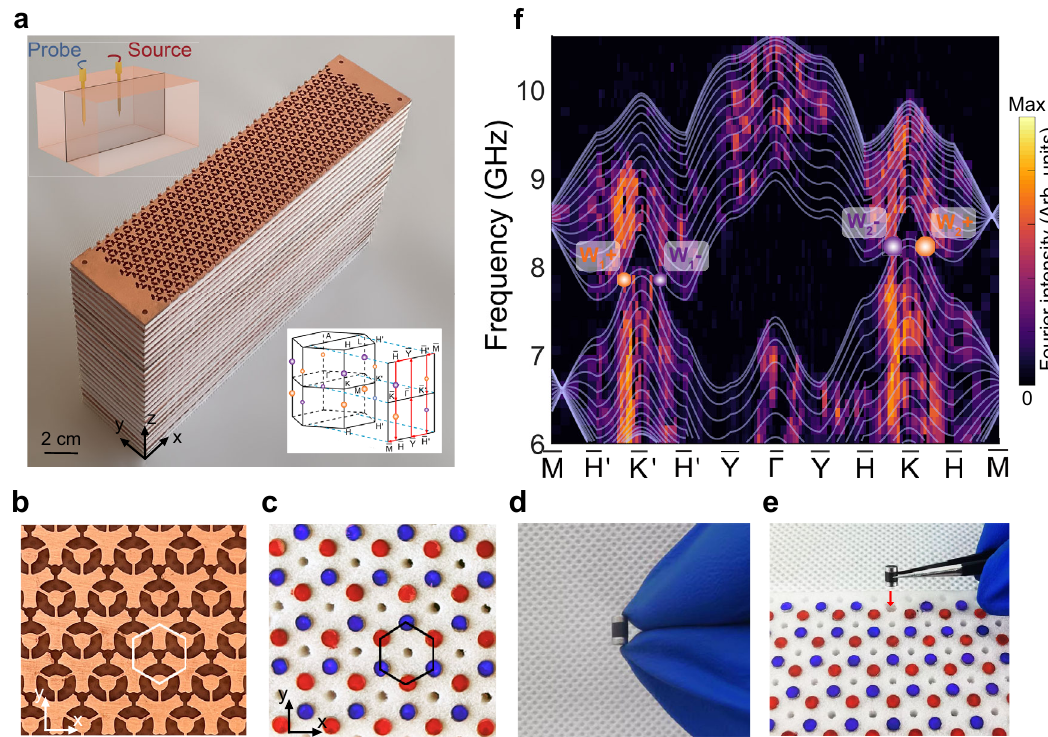
Fig. 2 | Experimental demonstration of a 3D magnetic Weyl photonic crystal. a Photograph of the fabricated 3D gyromagnetic photonic crystal that consists of 30 layers in the z direction and 30×10 unit cells in the x - y plane. Left upper inset: schematic of the experimental setup for measuring the bulk band structure. Right lower inset: 3D bulk BZ and projected surface BZ with two pairs of WPs. b , c Enlarged photographs of the perforated copper plates and dielectric foams, respectively.Redandbluedisksdenotethemagnetizeddirectionsofgyromagnetic